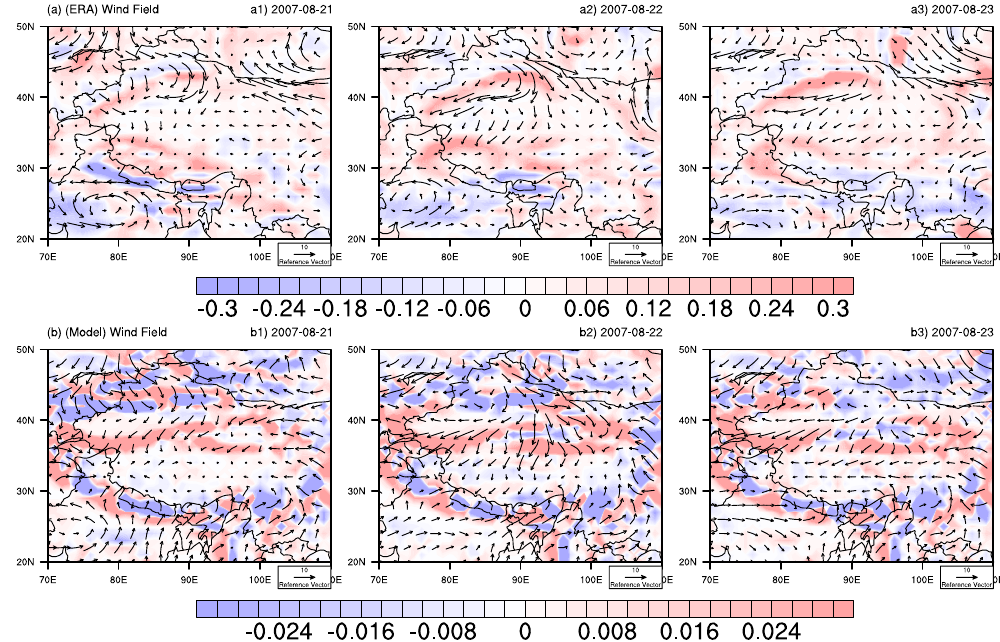
Figure 7. (a) Wind field from ERA-Interim at the 850hPa level (arrows for the U and V components of the horizontal wind, units: ms − 1 ; colors for the vertical wind velocity, the unit is Pas − 1 and the values are negative for updrafts and positive for downdrafts) from 21 to 23 August 2007. (b) Same as (a) but for the simulated wind field at 20m (units: ms − 1 , the values of the vertical wind velocity are negative for downdrafts and positive for